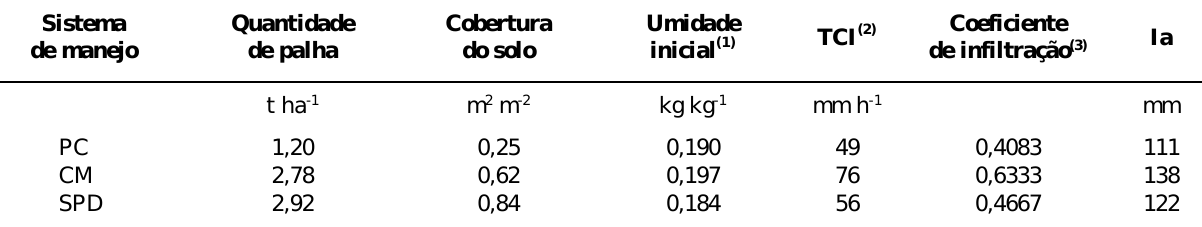
(1) Umidade inicial média da profundidade de 0-30 cm. (2) Para uma chuva simulada planejada de 120 mm h -1 . (3) Razão entre a taxa constante de infiltração e a intensidade de chuva planejada